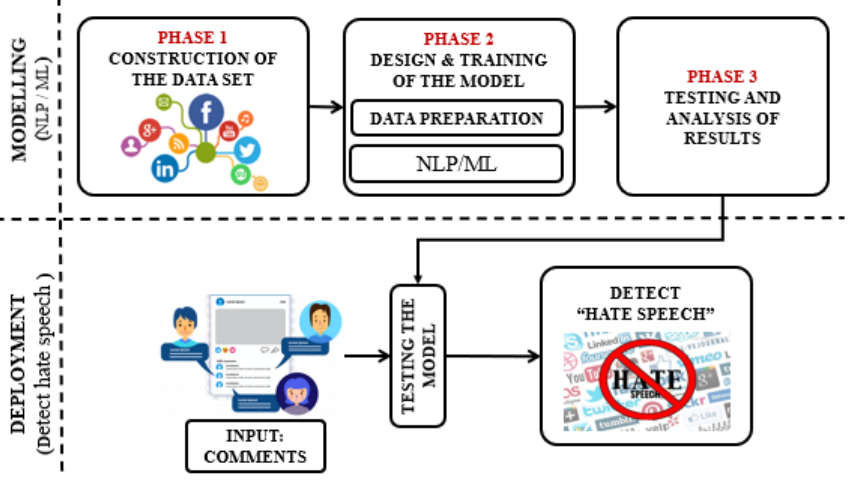
Figure 1. Methodology of the anti-sexism alert